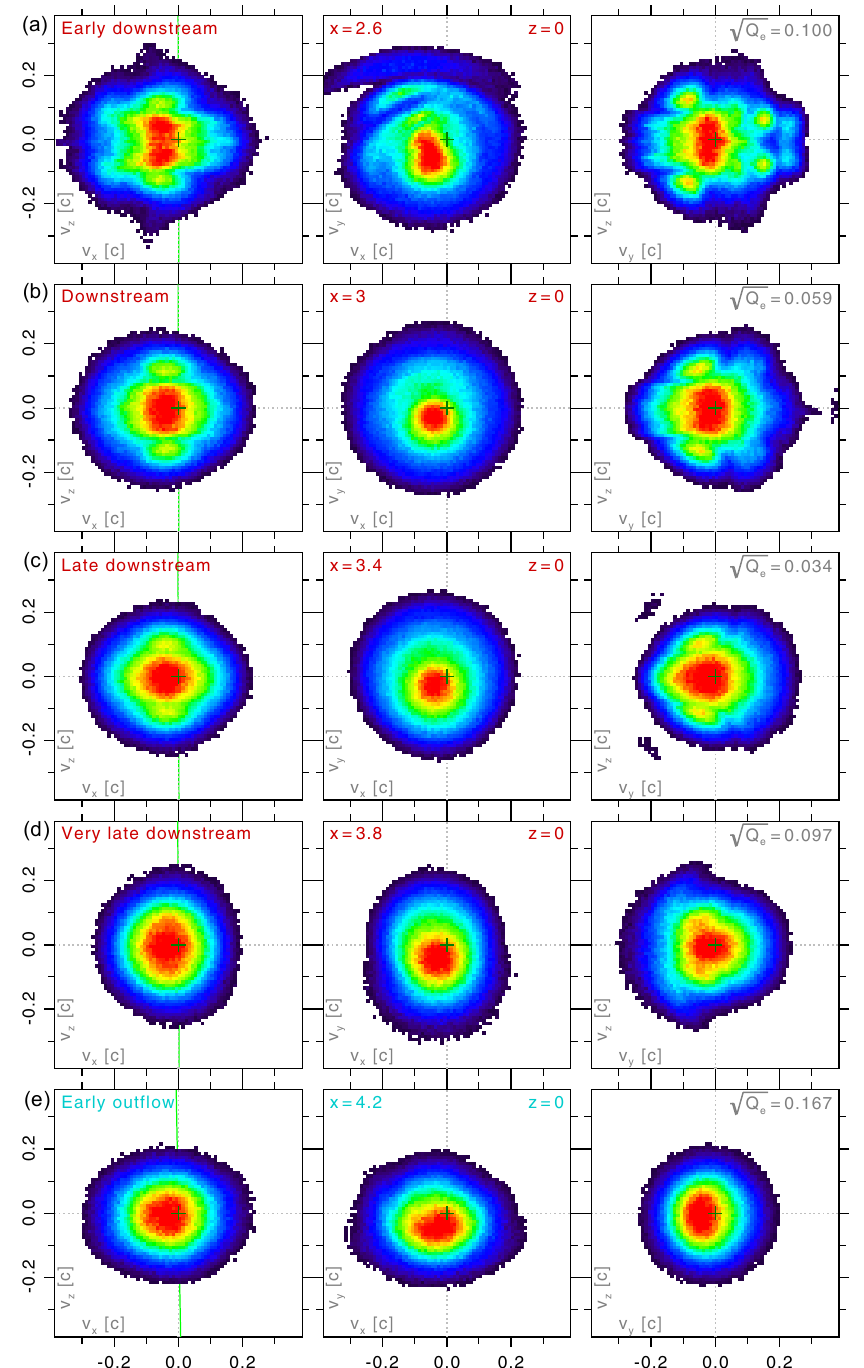
Figure 8. Same as Fig. 5 but downstream of the acceleration and towards the